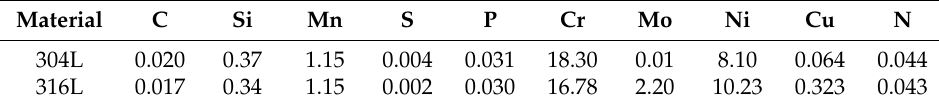
Table 1. Chemical compositions of the 304L and 316L ASSs used (in